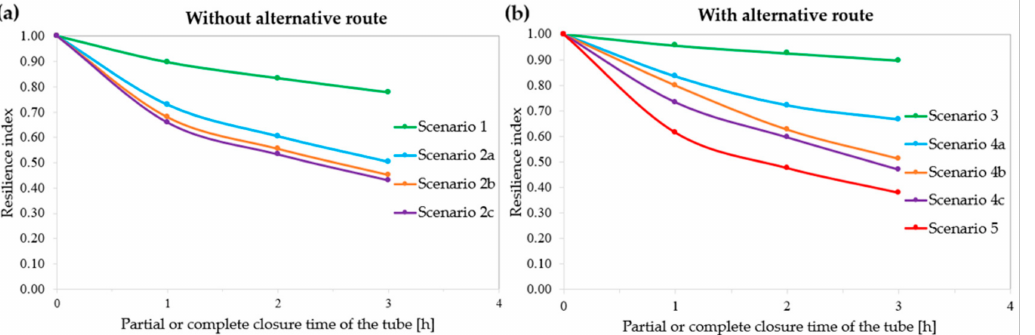
Figure 10. Resilience index of both the motorway section containing the tunnel tube investigated and the corresponding road network for the different scenarios investigated as a function of the partial or complete closure time of the north tube: ( a ) without alternative route, ( b ) with alternative route. Scenario 1: partial closure of the north tube (only 1 lane is closed); Scenario 2: complete closure of the north tube and use of the adjacent one for bi-directional traffic with the traffic by-pass opening within 10 min (Scenario 2a), 20 min (Scenario 2b), and 30 min (Scenario 2c), respectively; Scenario 3: partial closure of the north tube with alternative itinerary used by HGVs only; Scenario 4: complete closure of the north tube and use of the adjacent one for bi-directional traffic with alternative itinerary used by HGVs only, and traffic by-pass opening within 10 min (Scenario 4a), 20 min (Scenario 4b), and 30 min (Scenario 4c), respectively; Scenario 5: complete closure of the north tube with alternative itinerary used by all the